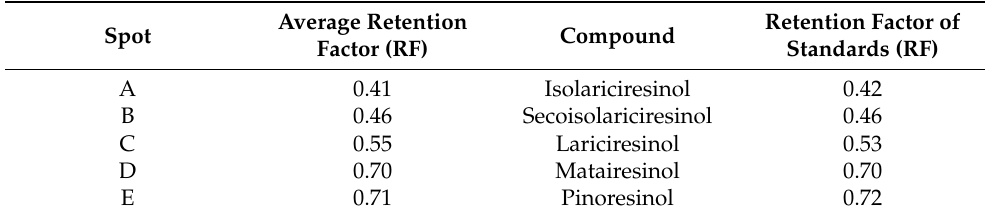
Figure 4. Developed TLC-plates of standards (left) and extracts of silver fir ( A. alba ) knots (right). matairesinol (Matai), pinoresinol (Pino), isolariciresinol (Iso-Lari), lariciresinol (Lari), secoisolariciresinol (Seco). Living knots (LK) and dead knots (DK). Table 2. Retention factors of spots on TLC chromatograms of silver fir ( A. alba ) knots extracts; compounds represented by spots and retention factors of standards.